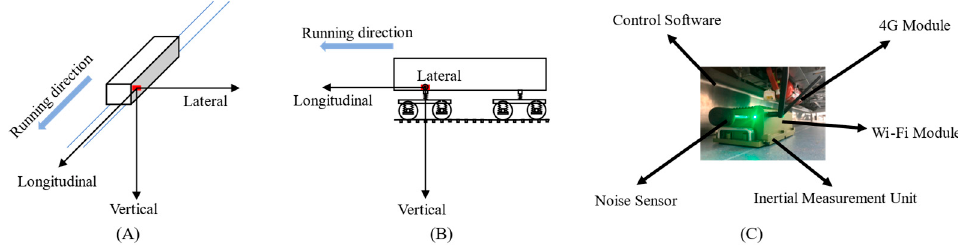
Figure 3. ( A ) CVD coordinate system; ( B ) CVD acquisition location; ( C ) structure of the portable detector.